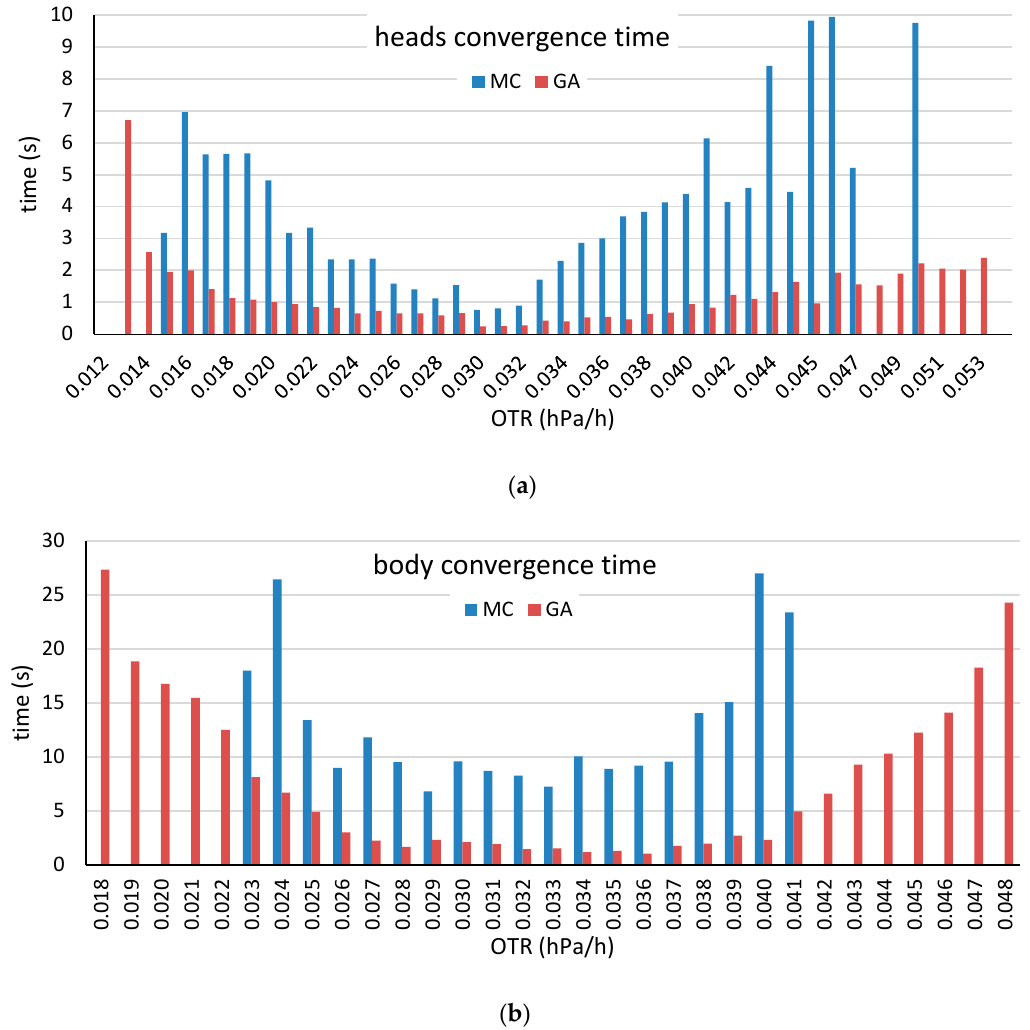
Figure 8. Mean convergence times of the head stave ( a ) and the body stave ( b ) by selection method for various target OTR values. The mean time was calculated considering only the heads and bodies that were constructed prior to reaching the maximum iteration time.